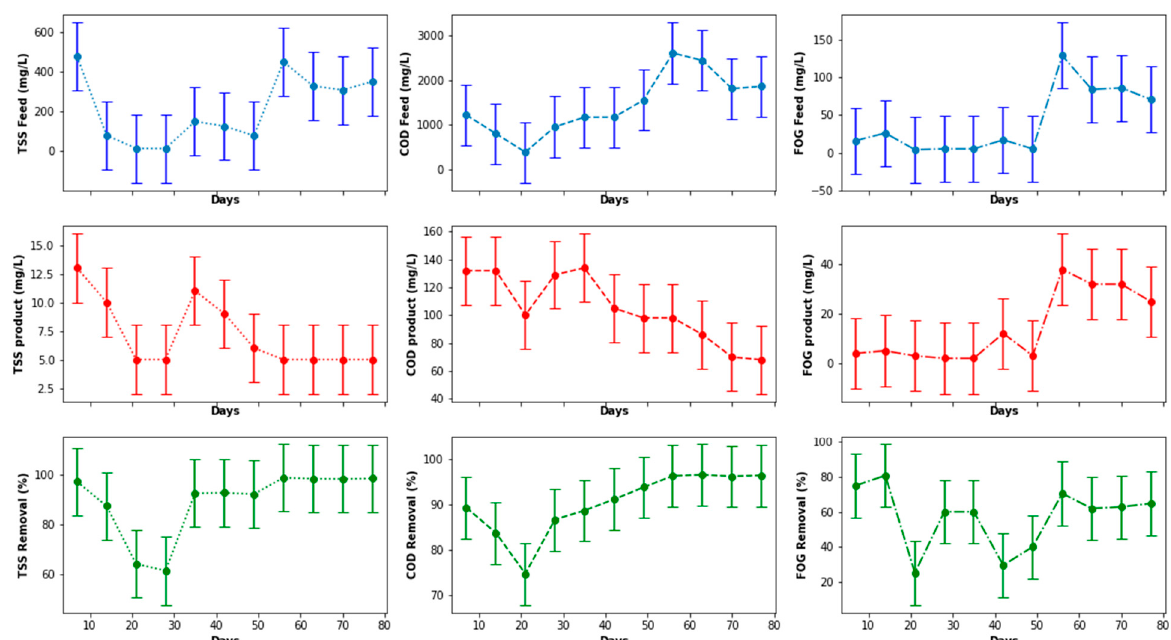
Figure 14. MBR performance with respect to COD, TSS, and FOG removal.